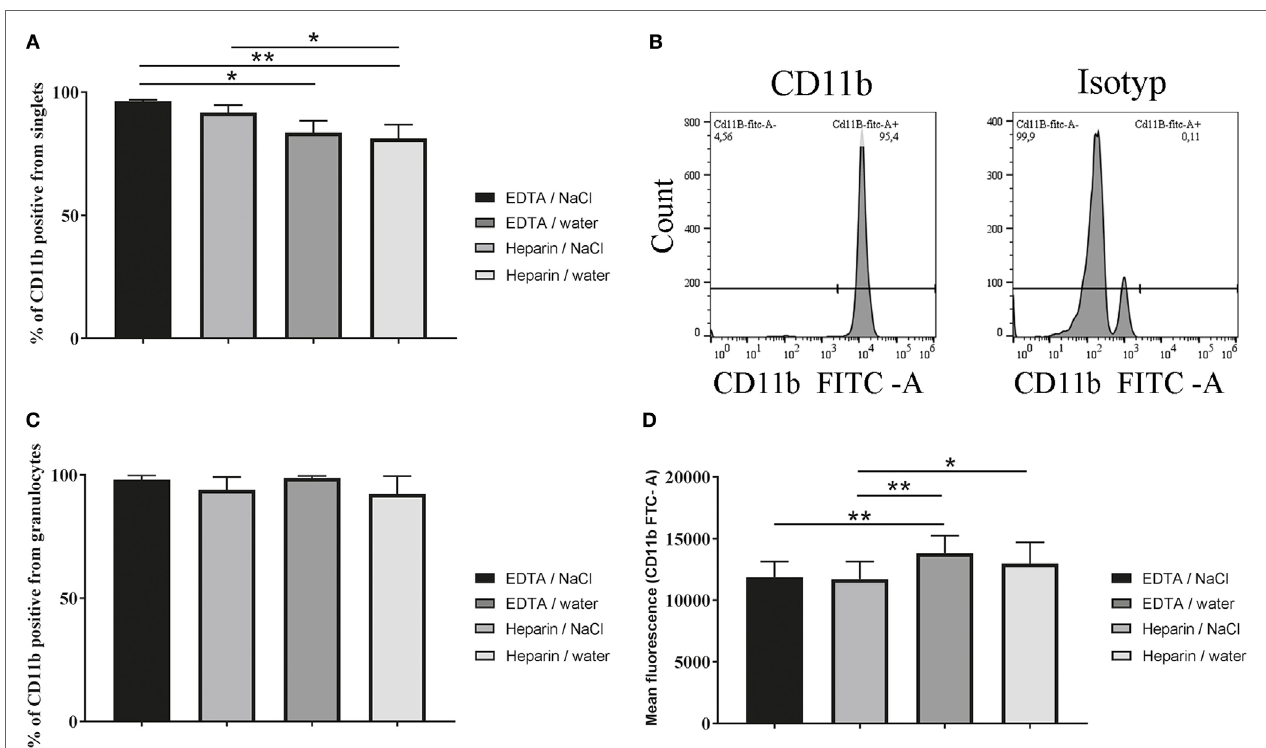
FIGUrE 4 | Percentage of CD11b positive cells and mean fluorescence intensity of CD11b positive granulocytes. CD11b expression of granulocytes was analyzed after isolation by flow cytometry with CD11b-specific FITC-labeled antibodies. (A) Percentage of CD11b positive cells from harvested cells (singlets) was significantly different ( n = 5, one-way ANOVA P = 0.0033). (B) Scatter blots are representative for the used settings and show the count in CD11b stained samples and the isotype control after K 3 EDTA/NaCl isolation. (c) Percentage of CD11b positive cells from granulocytes (singlets) only after FSC/SSC gating as presented in Figure 3c was not significant different ( n = 5, one-way ANOVA P = 0.3896). (D) By FACS the mean fluorescence intensity of CD11b expression level was analyzed on isolated granulocytes comparing the isolation methods ( n = 5, one-way ANOVA P = 0.0008). One-way ANOVA was followed by Tukey’s multiple comparisons test. P values * P < 0.05 and ** P < 0.01 were considered